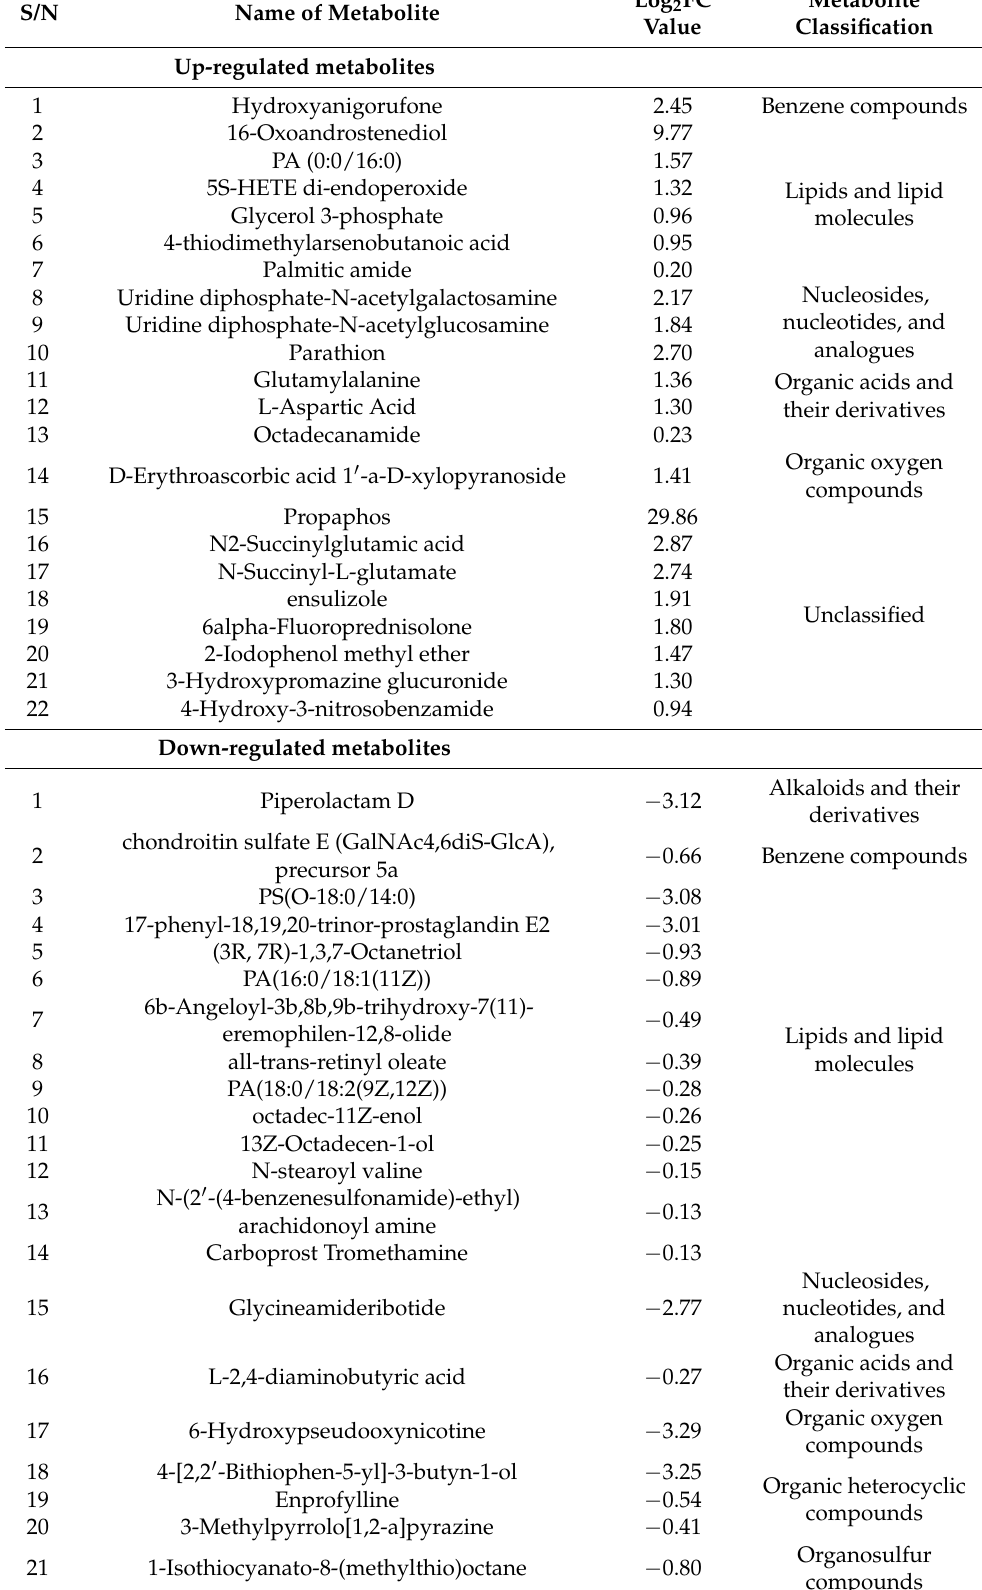
Table 2. List of differential metabolites in the 24 h 0.5 A-24 h CK